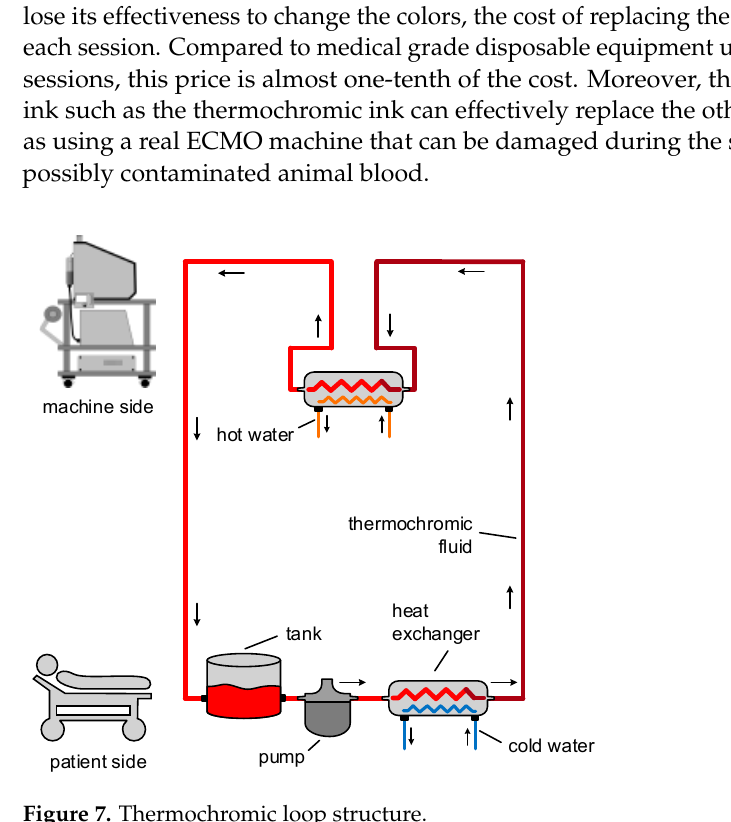
Figure 7. Thermochromic loop structure.